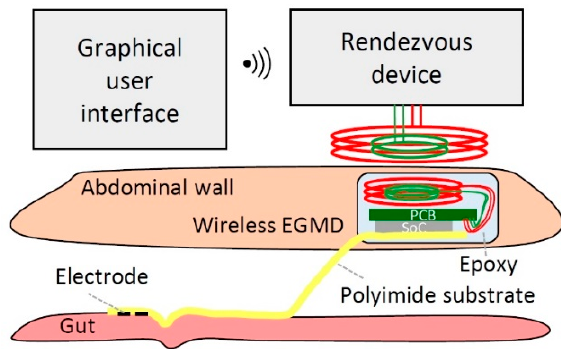
Figure 1. Illustration of wireless gastrointestinal (GI) modulation system interfacing with gut.